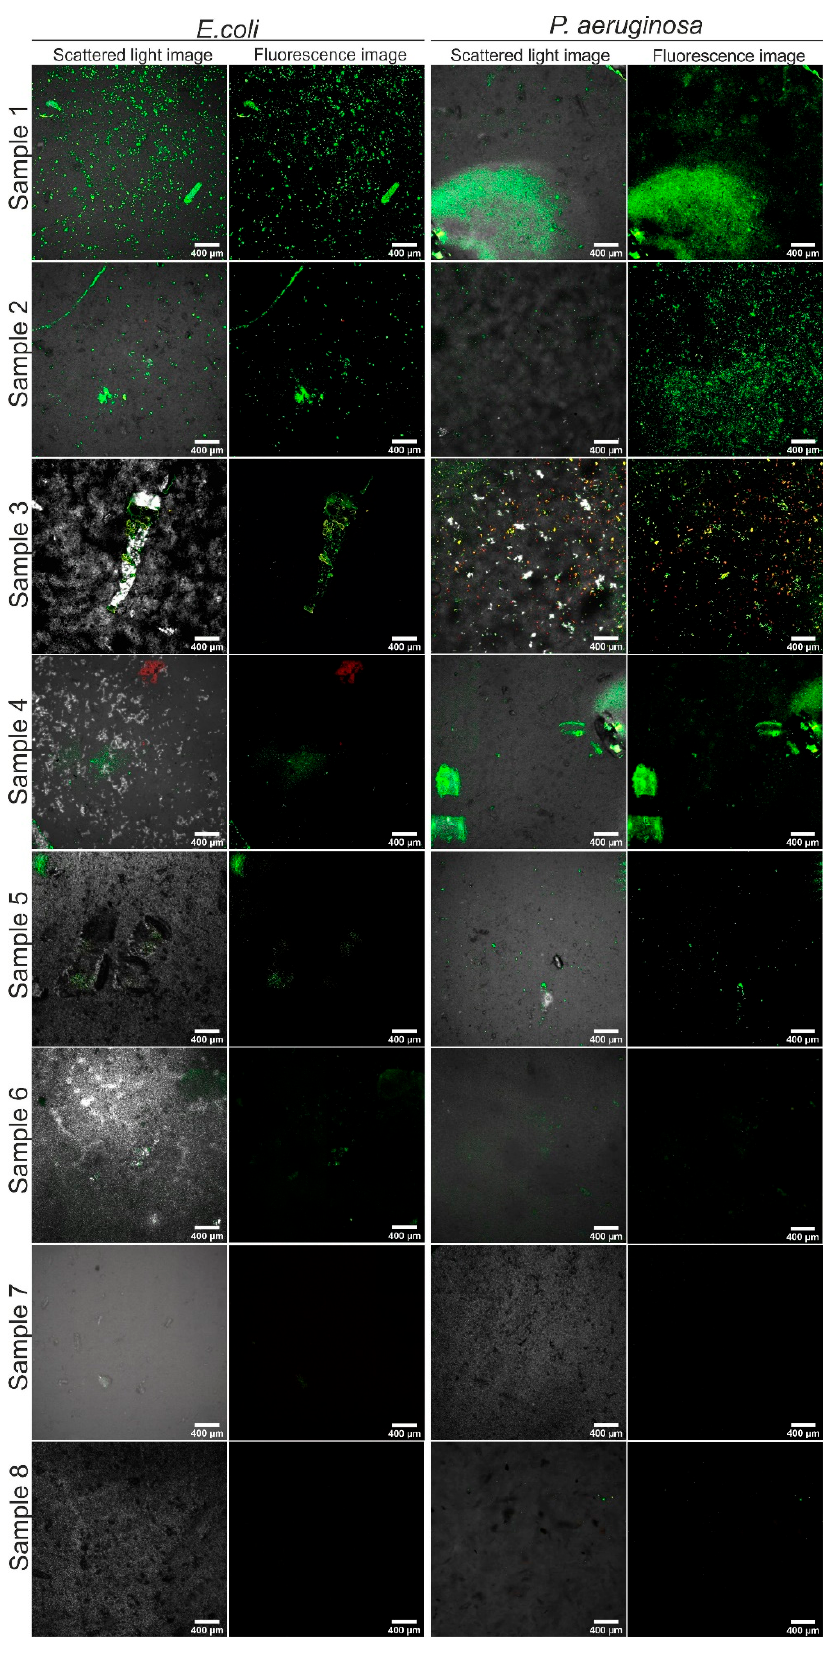
Figure 5. Confocal laser scanning microscope CLSM images showing Gram-negative strains biofilm formation (after 48 h of incubation) on tested materials: 1, control unmodified; 2–8, modified materials; magnification 40×; scale bar = 400 μ m.